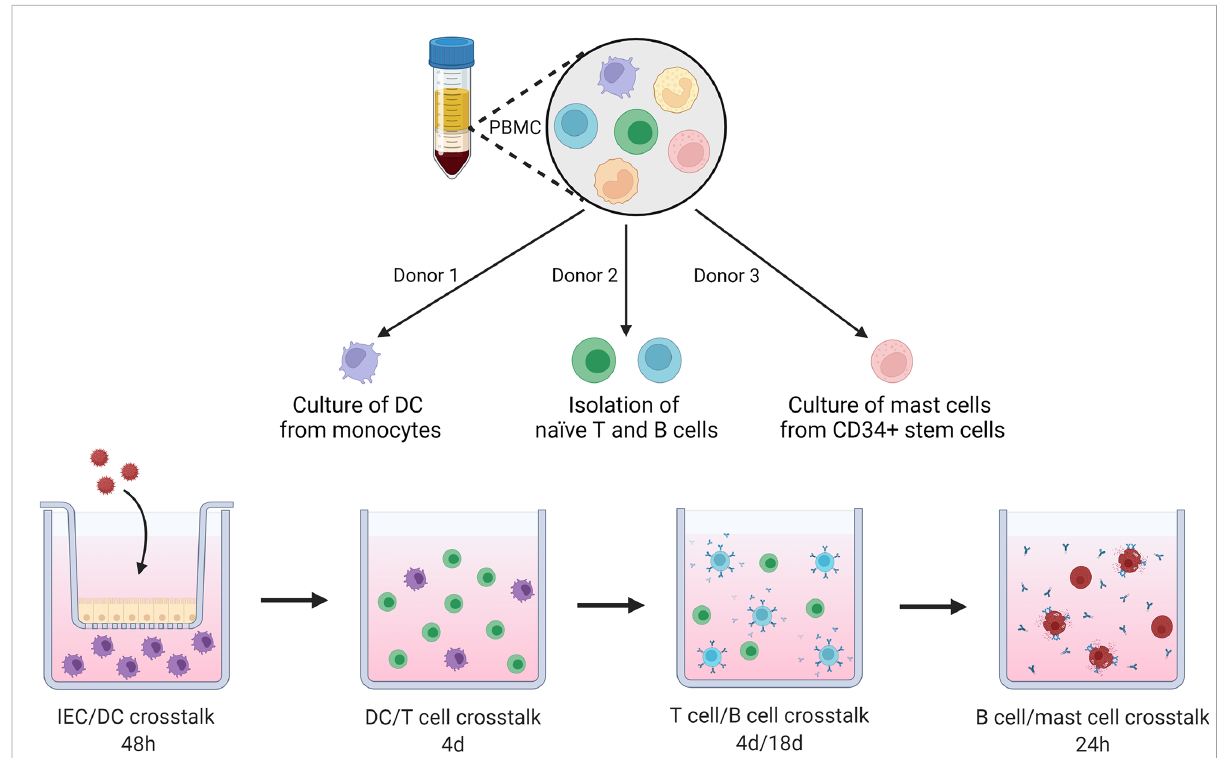
FIGURE 1 Schematic overview of coculture steps in this novel sequential mucosal food sensitizing allergenicity model. PBMCs are isolated from 3 donors, from the fi rst donor, moDC are cultured from isolated monocytes. The second donor provides naïve T and B cells. The third donor is used to isolate CD34+ stem cells which are differentiated into primary human mast cells. moDC are exposed to OVA in presence or absence of IEC for 48h, primed moDCs are collected and cocultured with naïve Th cells in a 1:10 ratio for 4 days. Next, the primed Th cells are cocultured with naïve B cells for 4 and 18 days. The B cell activation status was assessed after 4 days. After 18 days of coculture supernatant was collected to determine antibody secretion and for incubation with primary human mast cells overnight. IgE speci fi c mast cell degranulation was measured as well as cytokine secretion during a fi nal 18h incubation of the primed mast cells. This fi gure was created with